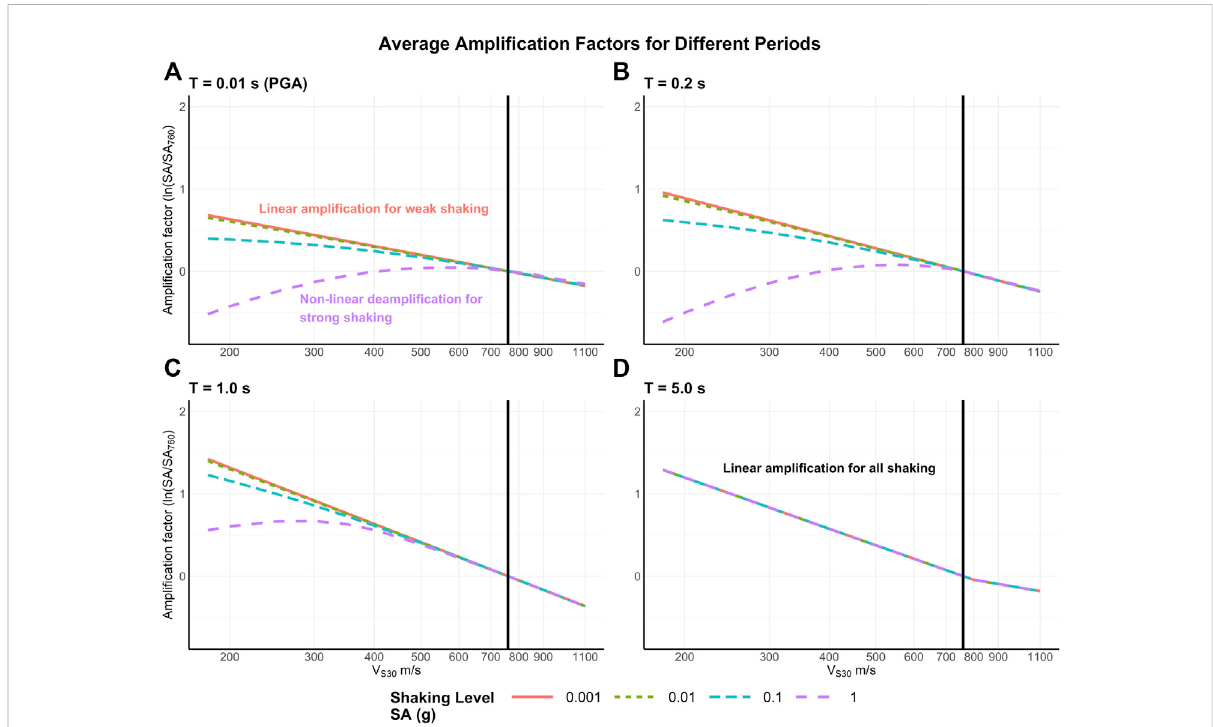
FIGURE 3 Site ampli fi cations and deampli fi cations versus V S30 for different periods (A) T = 0.01 s (PGA), (B) T = 0.2 s, (C) T = 1.0 s and (D) T = 5.0 s and the average ground-motion model. Nonlinear effects decrease for longer-period shaking. The vertical black line corresponds to V S30 = 760 m/s. An ampli fi cation factor of 0.0 indicates that the shaking with site effects is the same as that without site effects. Different lines indicate various shaking levels. Periods of 1.0 s correspond roughly to a 10-story building. SA is spectral